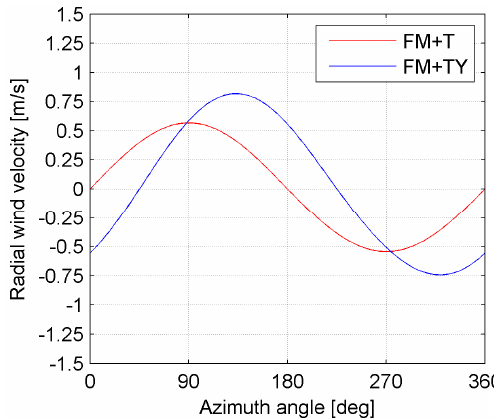
Figure 21. Computed impacting radial wind velocity at 75% of the blade span (see Figure 4 for the sign convention).